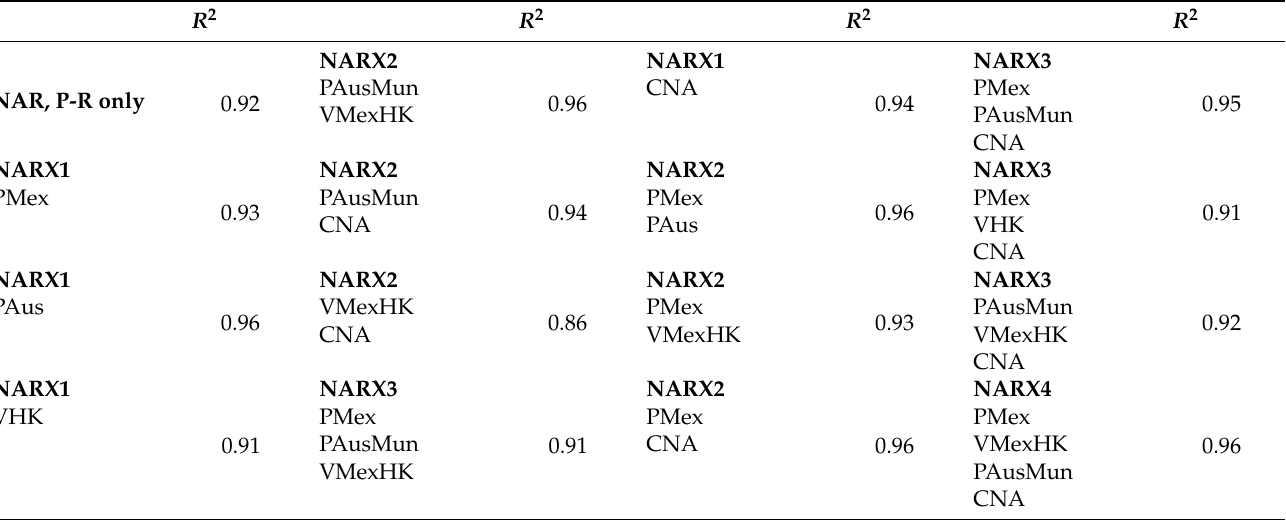
Table 3. Goodness of fit ( R 2 ) of the NAR and NARX models with the exogenous variables selected relative to the export price of the Mexican lobster to